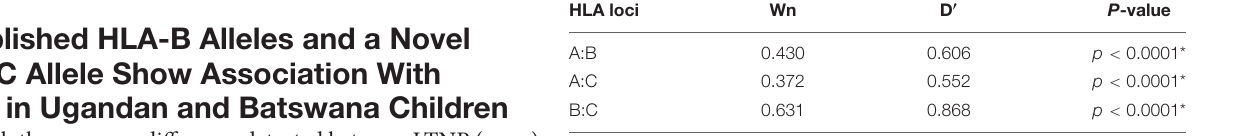
European and Hispanic groups (Cao et al., 2001; Kijak et al., Table 1 ), among the 56 alleles with frequencies > 1%, we identified three alleles with a significant positive association with LTNP status after adjusting for multiple testing and controlling for gender and country ( Pc < 0.05, Figure 4 and Table 3 ) - HLA-